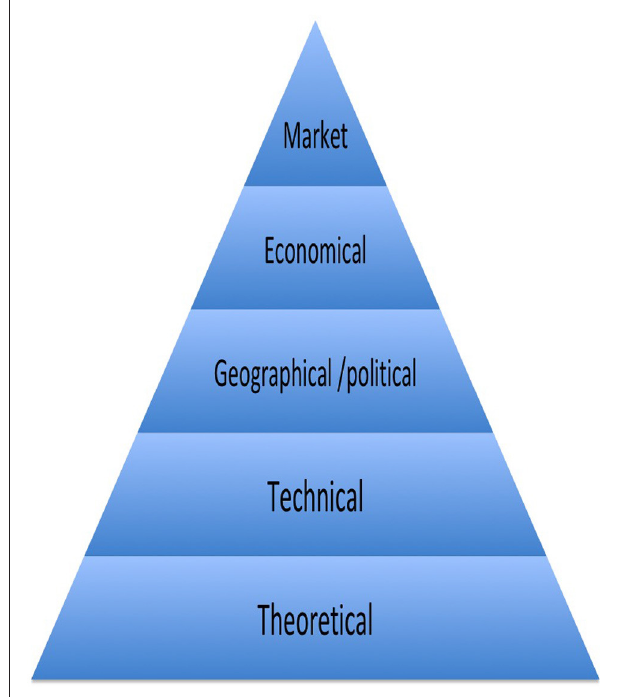
FIGURE 2 | The various forms of wind energy potential, described in more detail in